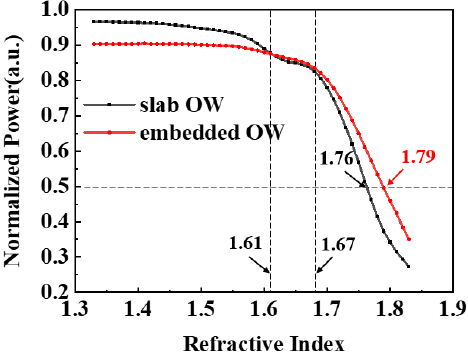
Figure 9. The comparison with the transmission loss of the embedded OW and that of the slab OW.